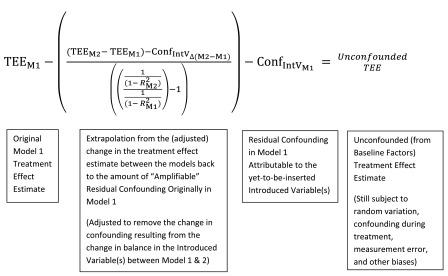
Components of the ACCE Method Summary Equation.